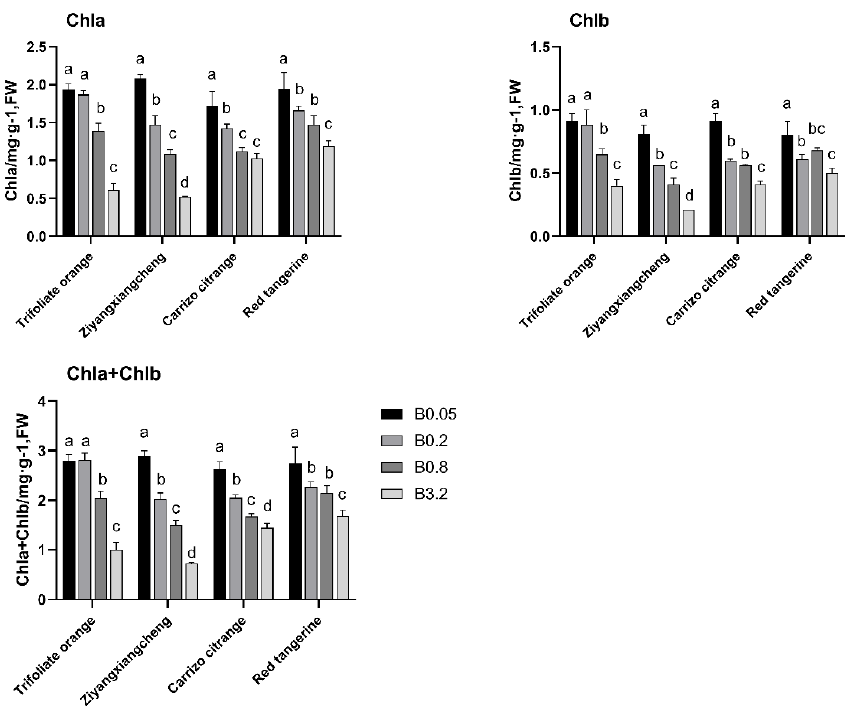
Figure 3. The impact of excess B stress on photosynthetic pigment levels in the leaves of four citrus rootstock seedlings. Note: B 0.05 served as the control (CK) concentration, and data were compared with Duncan’s multiple range test. Different letters indicate significant differences among B concentrations for the indicated rootstock ( p < 0.05). Table 4. The impact of excess B stress on the net photosynthetic rates in the leaves of four citrus rootstock seedlings.